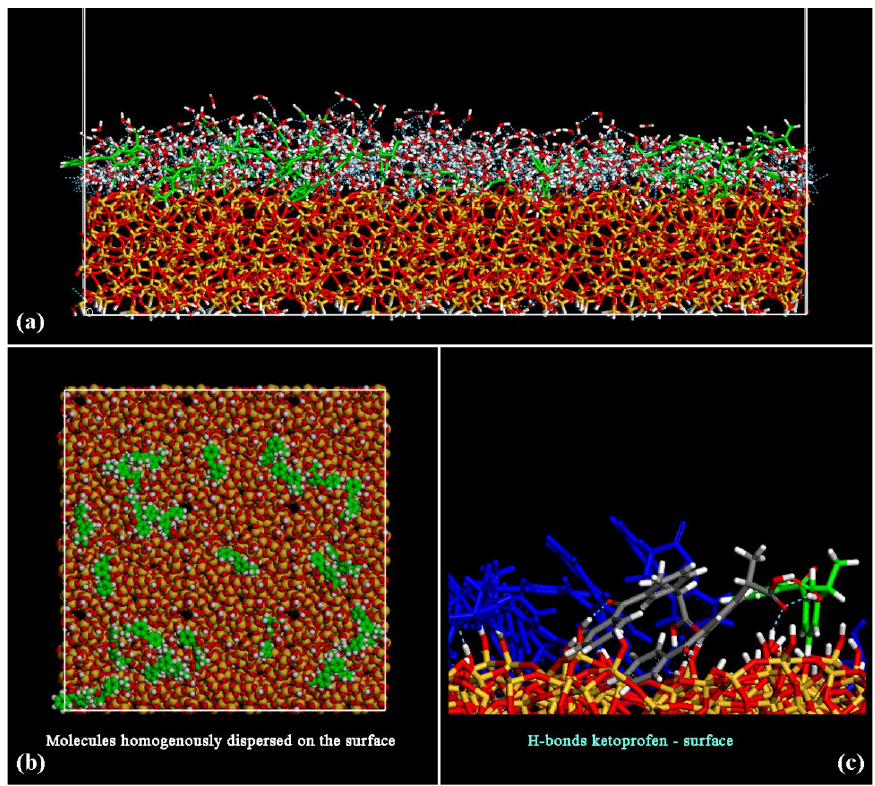
Figure 6. Optimized geometry after MD run of 28 ketoprofen drug molecules in racemic mixture adsorbed on hydrated amorphous SiO 2 surface, in particular side view in panel ( a ) and topo view in panel ( b ) without water molecules for clarity. For panels ( a ) and ( b ) the color code is the same of Figure 3. In panel ( c ) some ketoprofen molecules are in blue, some with carbon atoms in grey or in green in order to better show possible H-bonds in dashed light blue lines.